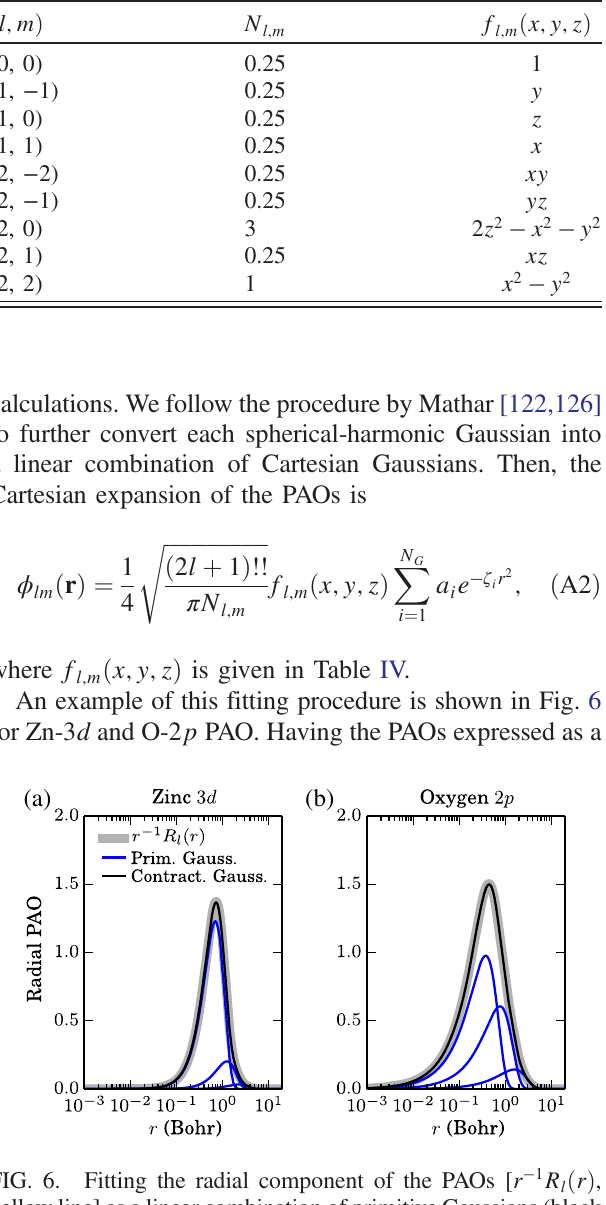
FIG. 6. Fitting the radial component of the PAOs [ r − 1 R yellow line] as a linear combination of primitive Gaussians (black line). Each contracted Gaussian is the sum of the three primitive Gaussians shown in blue. The Zn d (a) and O p PAOs (b) are taken from the PSlibrary